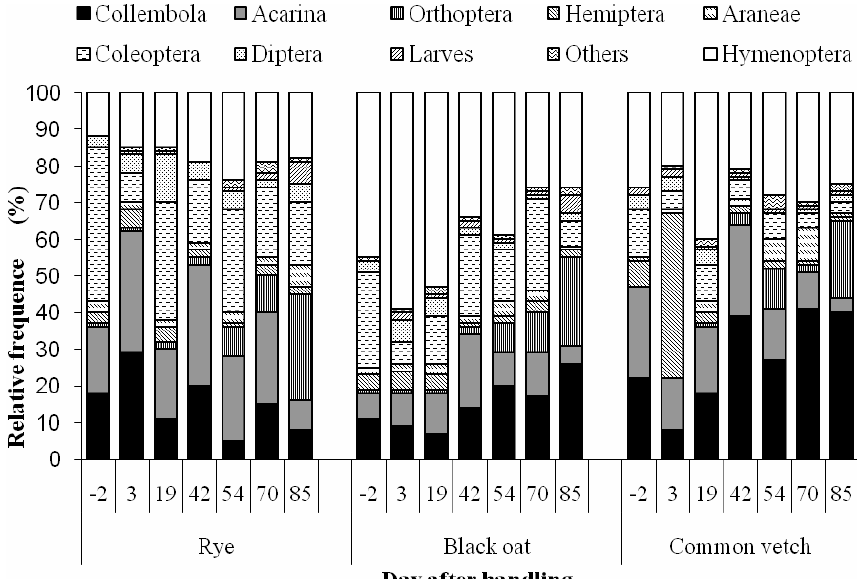
Figure 3. Relative frequency of main soil fauna groups at different times during decomposition of cover plant residues in no tillage system.